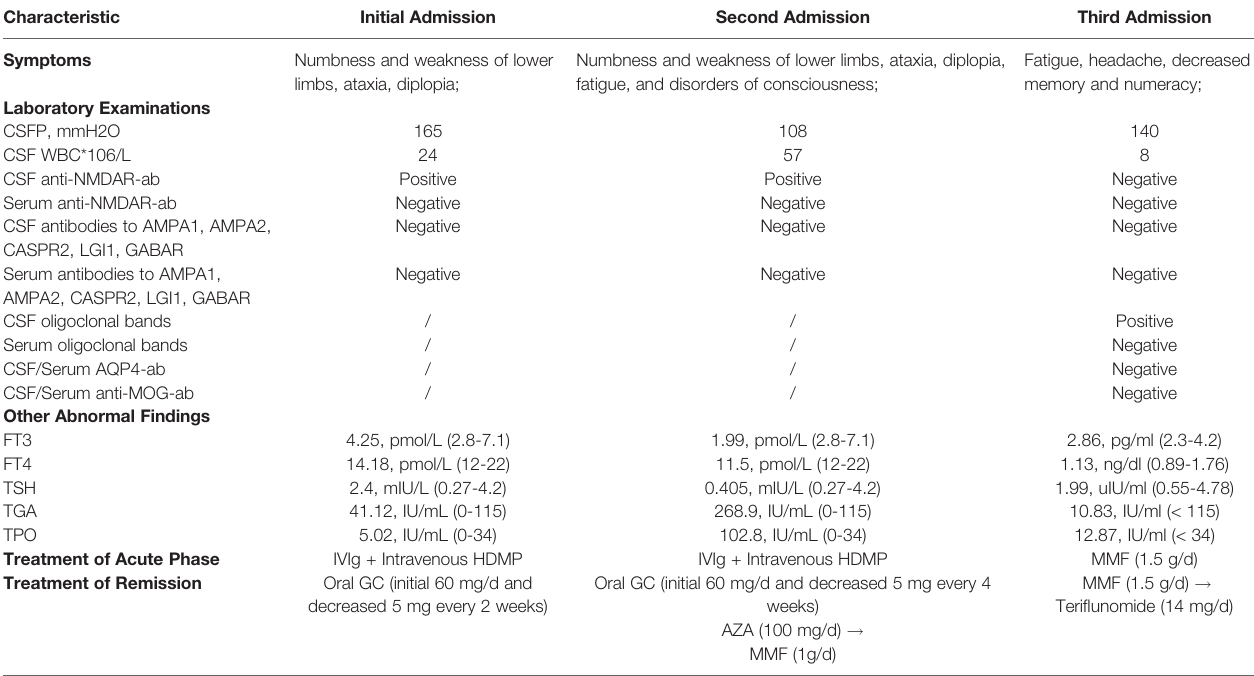
TABLE 1 | Clinical characteristic laboratory data and treatments in fi rst and relapse episode.